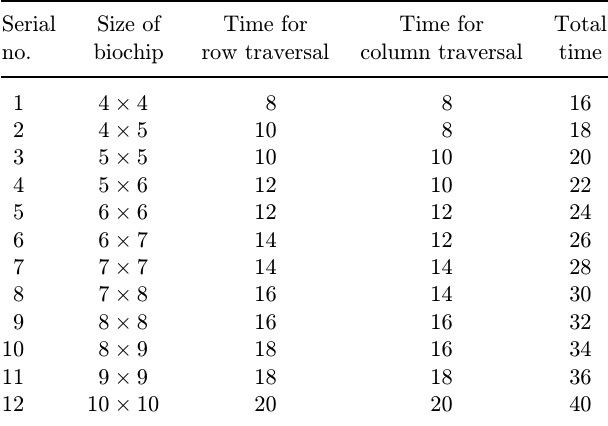
Table 1. Time taken to traverse a fault-free